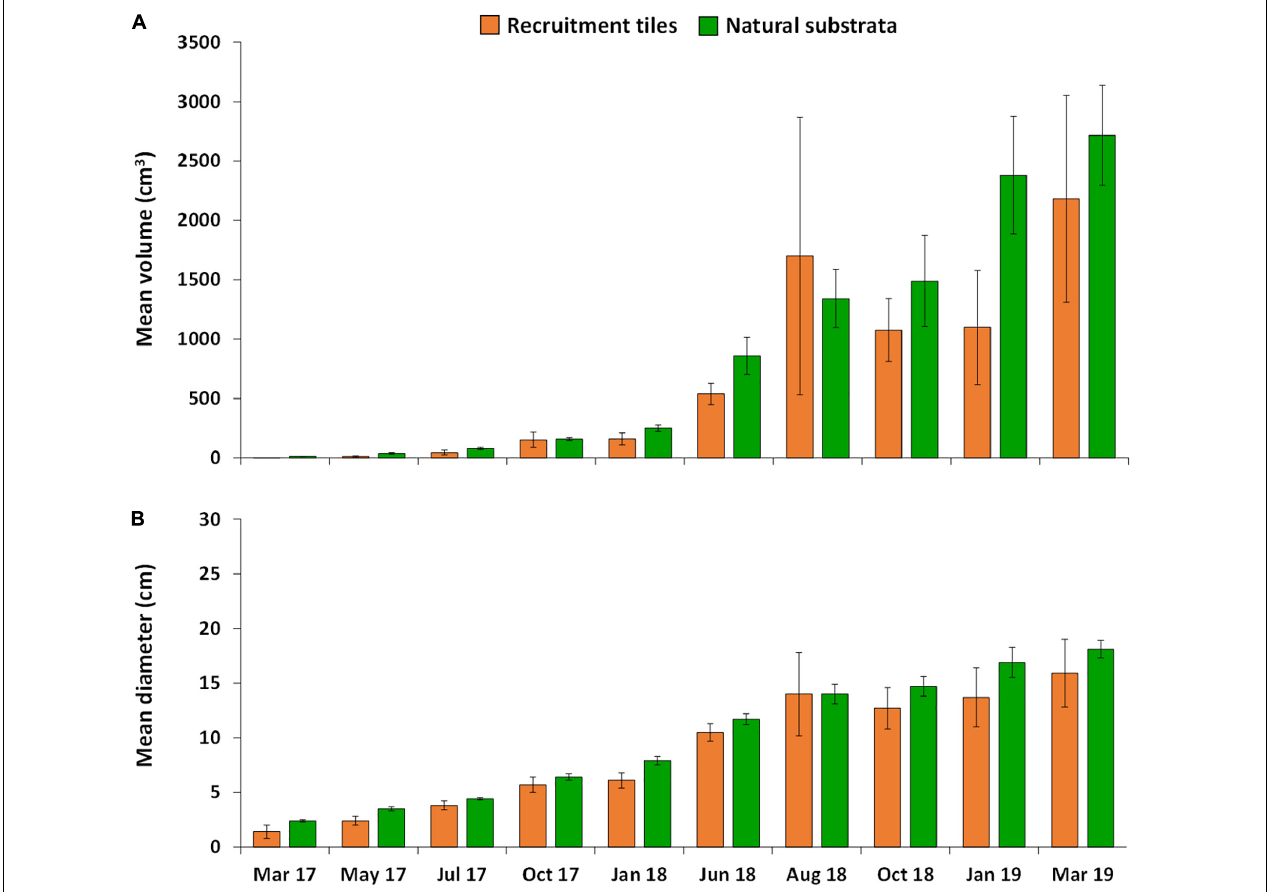
FIGURE 7 | Mean growth of A. tenuis colonies over 34 months in the three larval enhanced plots, (A) mean volume and (B) mean diameter of colonies on settlement tiles (orange) and natural substrata (green). Error bars are ± SE.